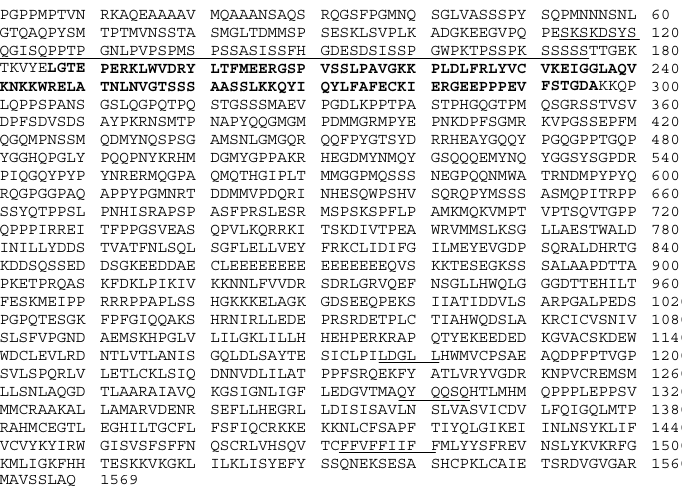
Figure 5. Analysis of the di ff erent parts of the rat 6A3-5 cDNA. Predicted 6A3-5 rat protein sequence (1569 aa). The ARID motif (187– 296) is shown in bold whereas LXXLL motif (1177–1181), serine-rich region (112–175), Q-rich region (1298–1304), and phenyl-rich region (1472–1481) are